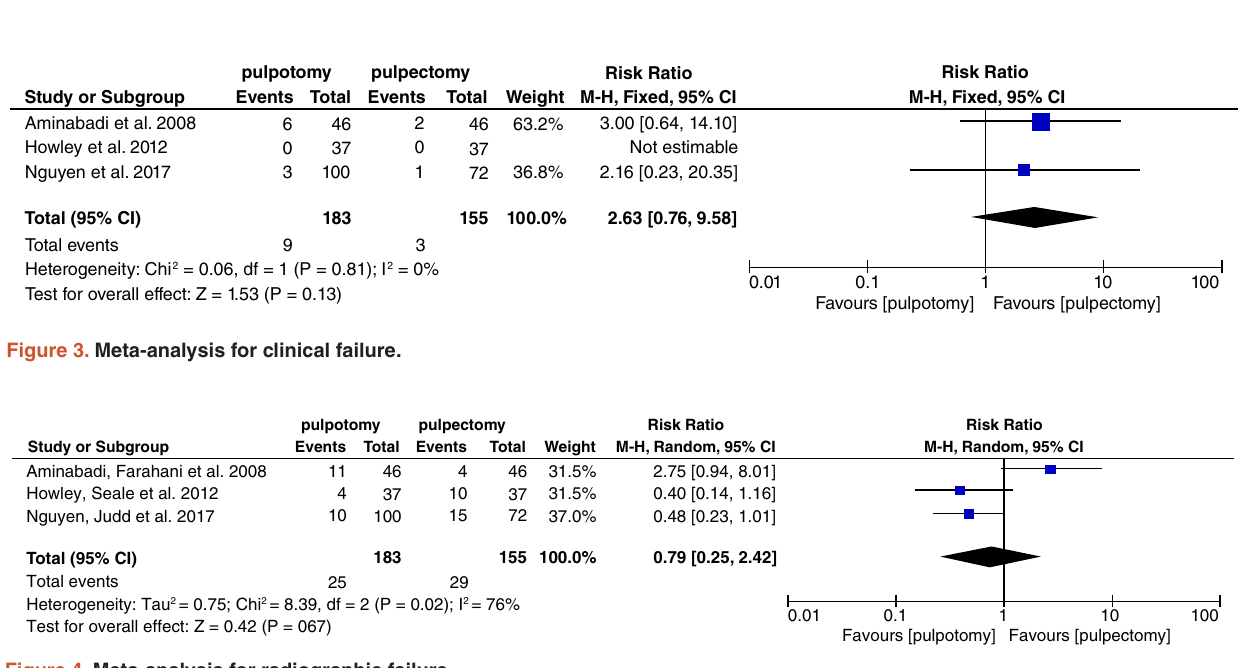
failure.Figure 2. Risk of bias summary of included